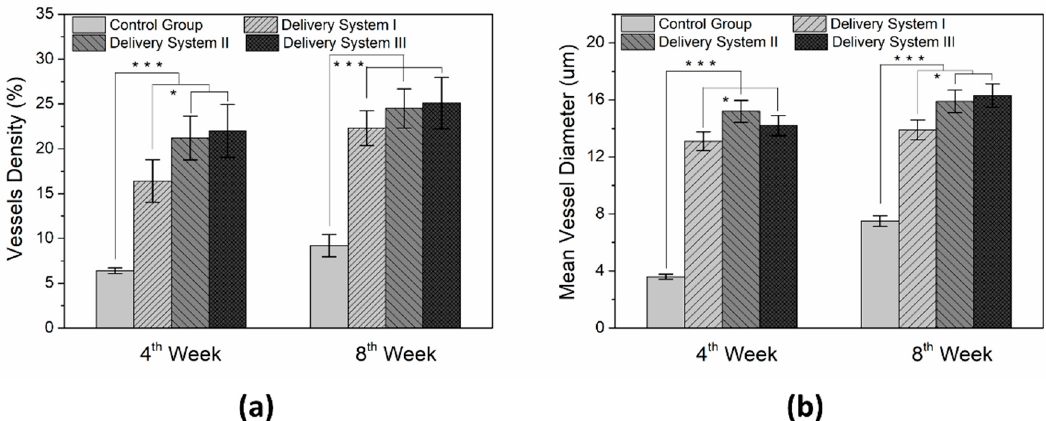
Figure 5. The vessels density and mean vessel diameter were analyzed by the ImageJ software quantitatively according to H&E and Masson stained slices after the implantation of the composite hydrogels with different delivery systems into the necrosis site of femur head in rabbits at the 4th and 8th weeks. ( a ) Vessels density increased over weeks for three delivery systems; ( b ) mean vessel diameter also increased over weeks for three delivery systems, and delivery system III showed the highest value at the 4th week. Non-intervention treatment as a control group (*** p < 0.001, * p < 0.05).